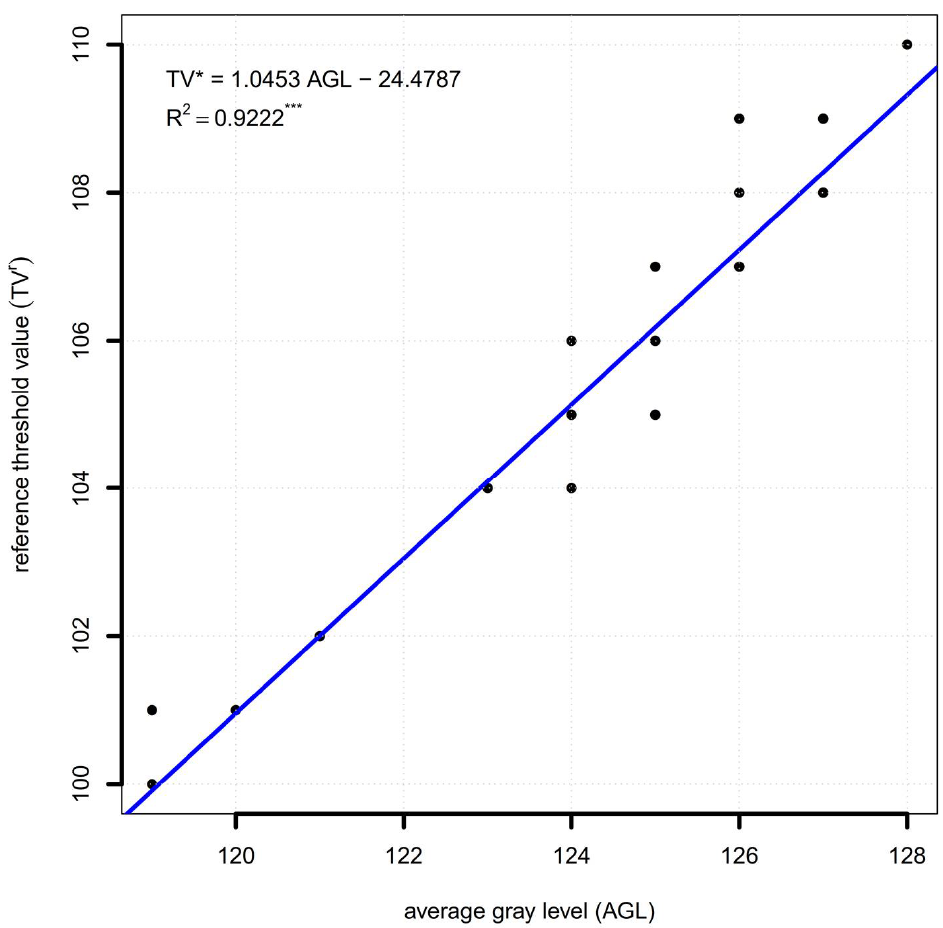
Figure 5. Relationship between the average gray level (AGL) of an image and the reference threshold value ( TV r ) used for segmentation (***: statistically significant at p -level = 0.001). The relationship was well described by the linear model (Equation